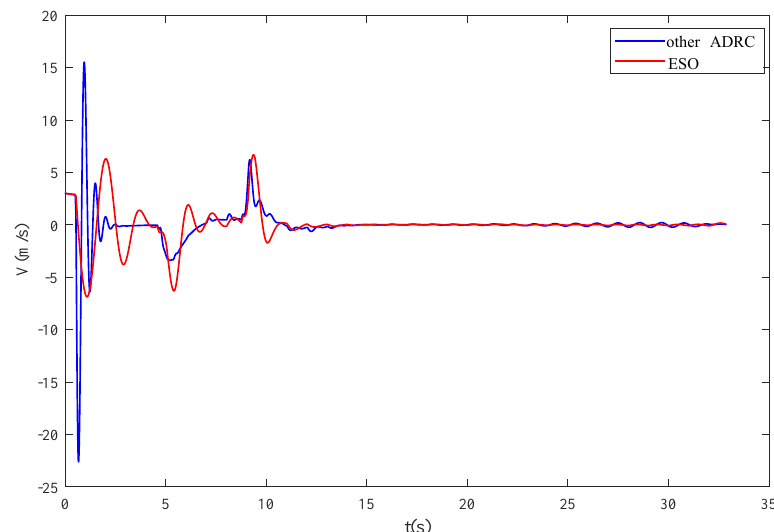
Figure 16. Comparison of roll angle response curves between different